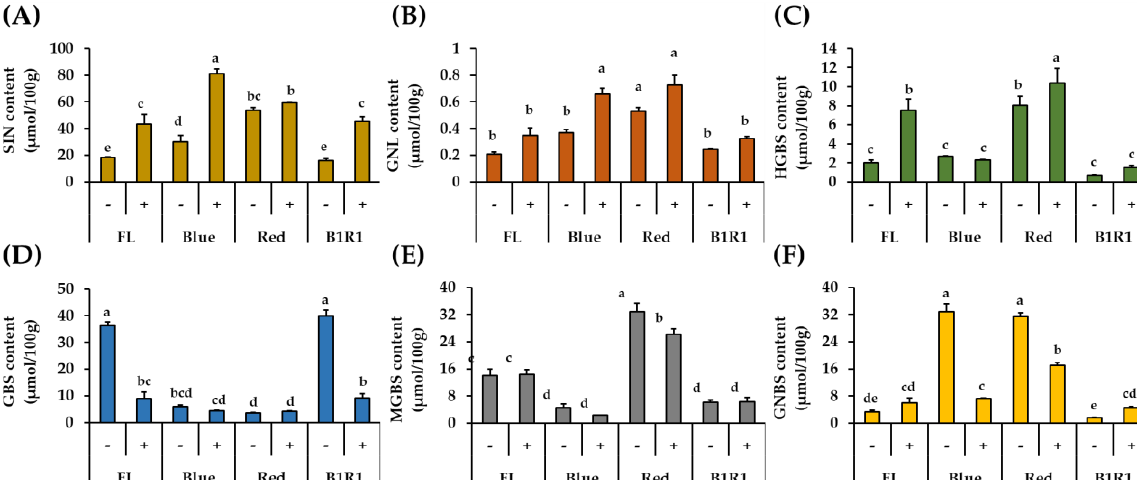
Figure 3. Quantification of DS-GLs (sinigrin ( A ), gluconapoleiferin ( B ), 4-hydroxy glucobrassicin ( C ), glucobrassicin ( D ), 4-methoxy glucobrassicin ( E ) and neoglucobrassicin ( F )) in microgreens exposed to fluorescent (FL), blue, red and a combination of blue plus red (B1R1) lights and cultivated in the absence (−) and presence (+) of salt stress. Data were expressed as mean ± standard error ( n = 3). ANOVA analysis was done using Duncan’s method and different letters on columns of each graph were used to show statistical significance ( p < 0.05).